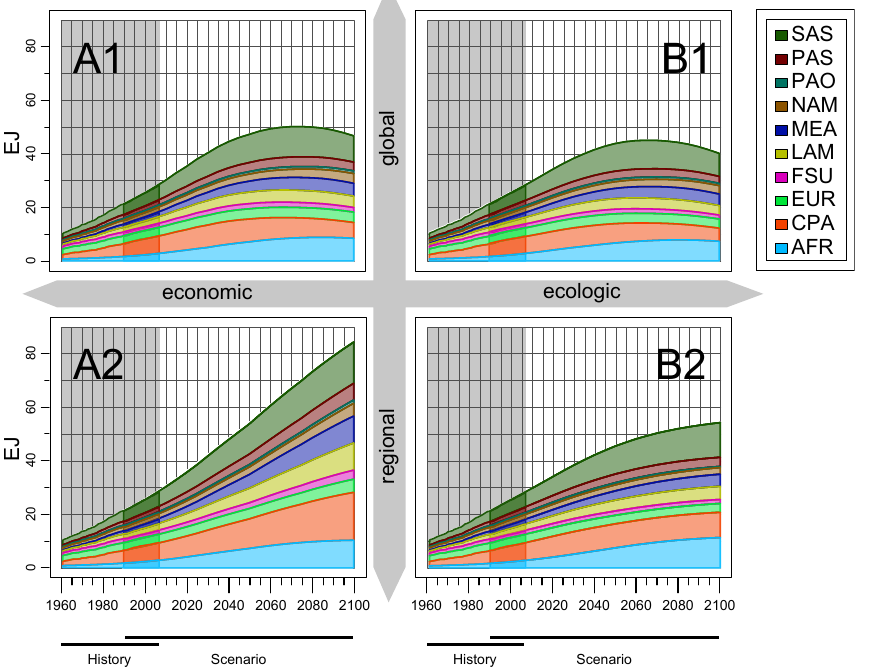
Fig. A2. Total food energy demand in the 10 MAgPIE world regions. History and future developments for the four SRES scenarios (Bodirsky et al., 2012).